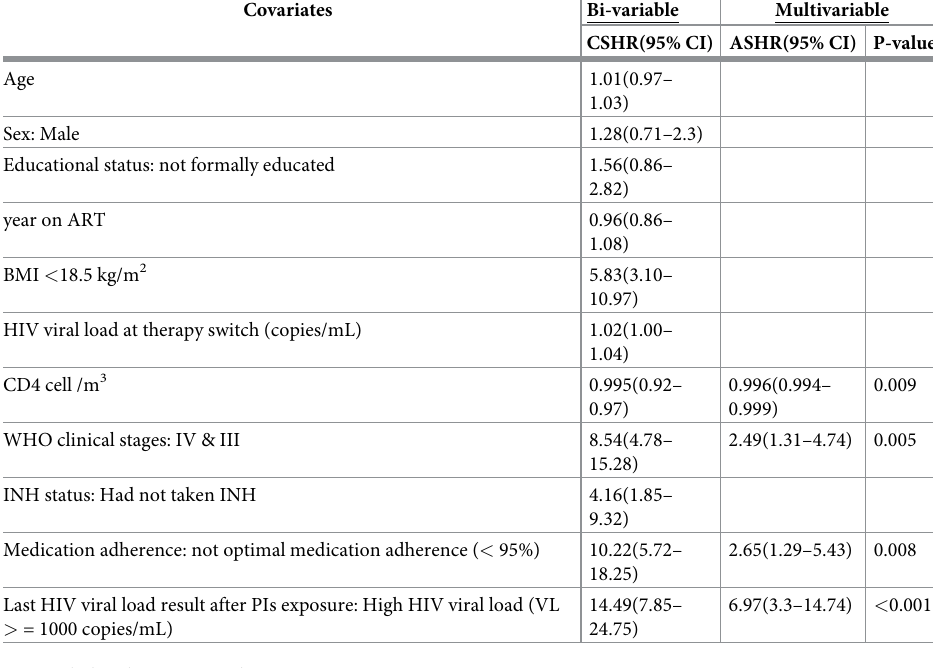
Table 5. Bi-variable and multivariable competitive risk model on determinants of death among PLWHIV on sec- ond-line therapy, Dessie Comprehensive Specialized Hospital, northeast Ethiopia, October 2016—November 19. (n =